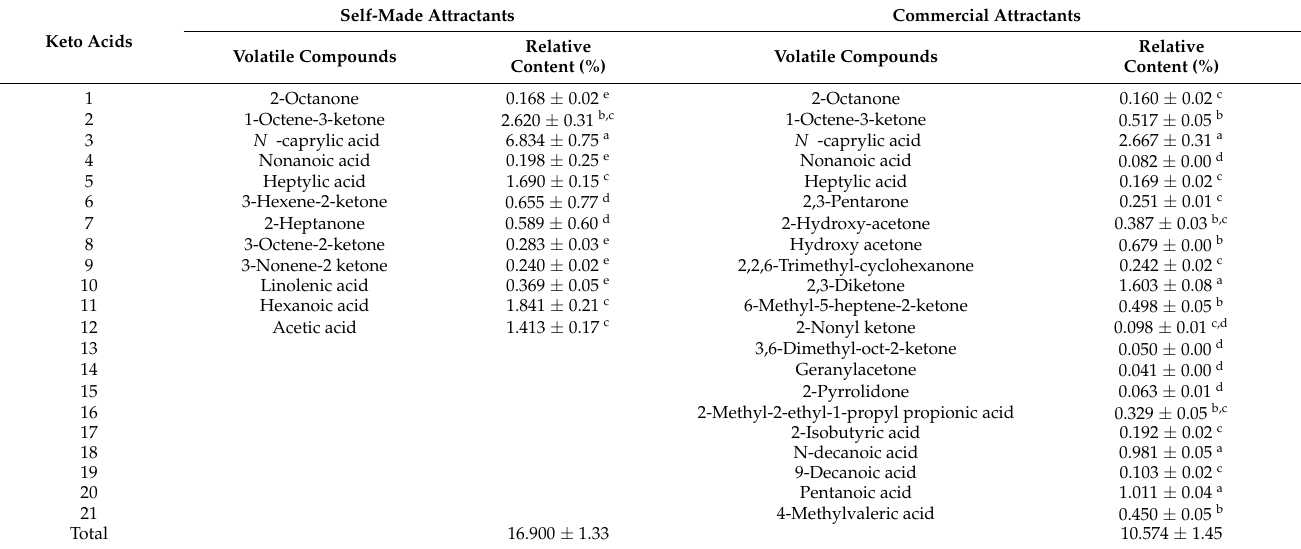
Table 5. Keto acids in self-made and commercial attractants (percentage of the total peak area).